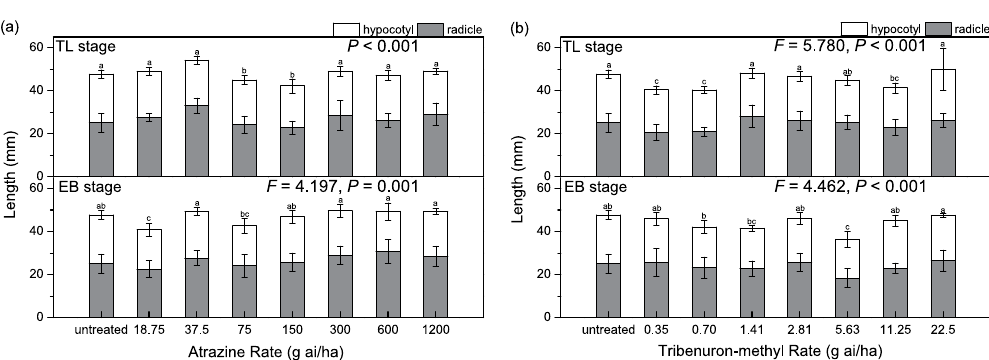
Figure 2. Length of radicle and hypocotyl of 7-day-old seedlings produced after the 12 to 14 true leaves stage (TL stage) and the early blooming stage (EB stage) treated with atrazine ( a ) or tribenuron-methyl ( b ). Here, and in Fig. 3, different letters indicate significant difference between different doses of the same herbicide at α = 0. 05; and the Kruskal-Wallis test results had no F